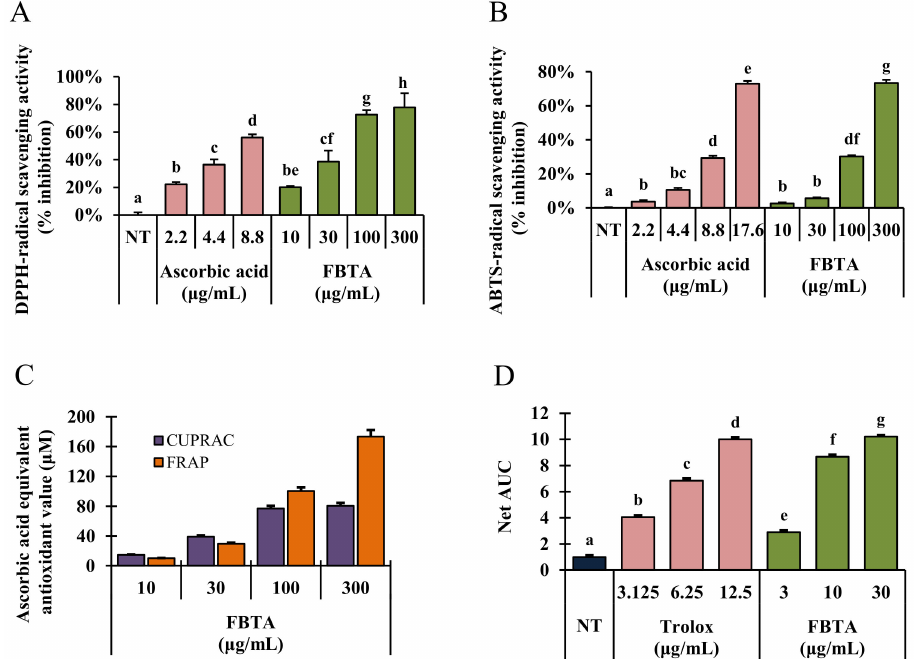
Figure 2. Cell free antioxidant activity of FBTA. ( A ) 2,2-diphenyl-1-picrylhydrazyl (DPPH-)